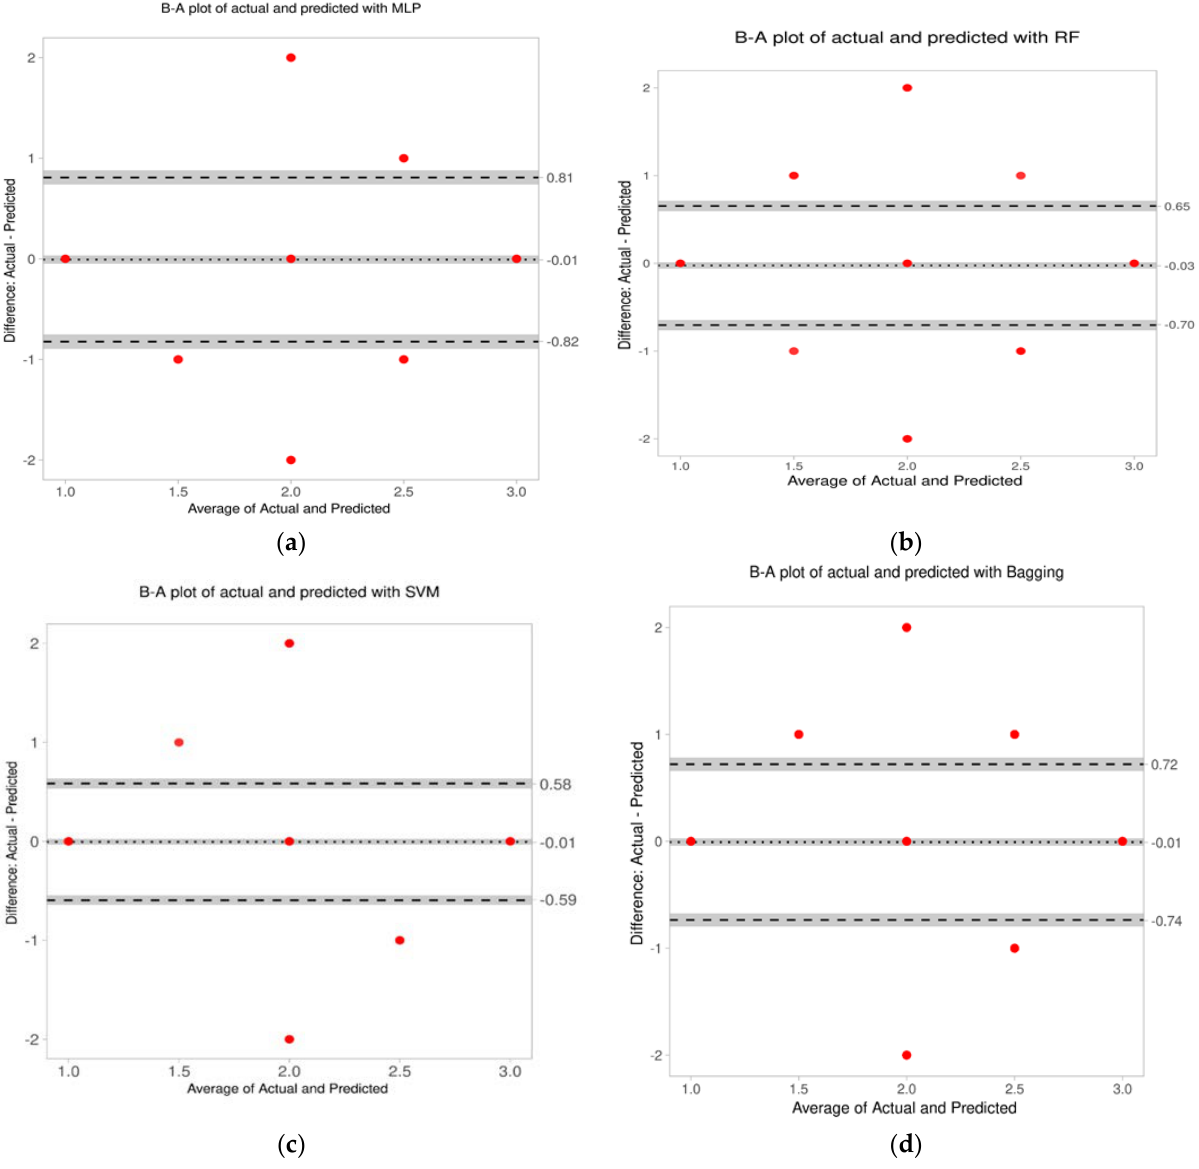
Figure 8. Bland–Altman plot of the actual and predicted classifications for all the classifiers. ( a ) For MLP, the average difference is −0.01 and the limits of agreement: −0.82 and 0.81. ( b ) For RF the average difference is −0.03 and the limits of agreement: −0.7 and 0.65. ( c ) For SVM, the average difference is −0.01 and the limits of agreement: −0.59 and 0.58. ( d ) For bagging the average difference is −0.01 and the limits of agreement: −0.74 and 0.72.